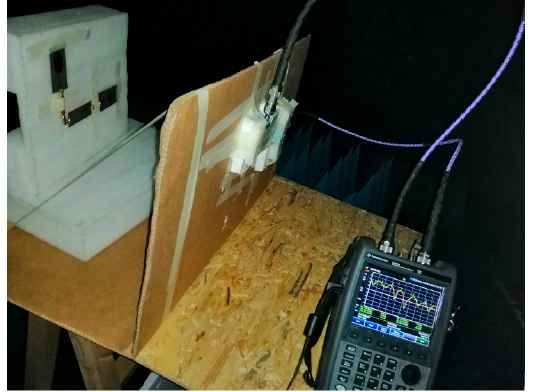
Figure 17. Measurement setup.